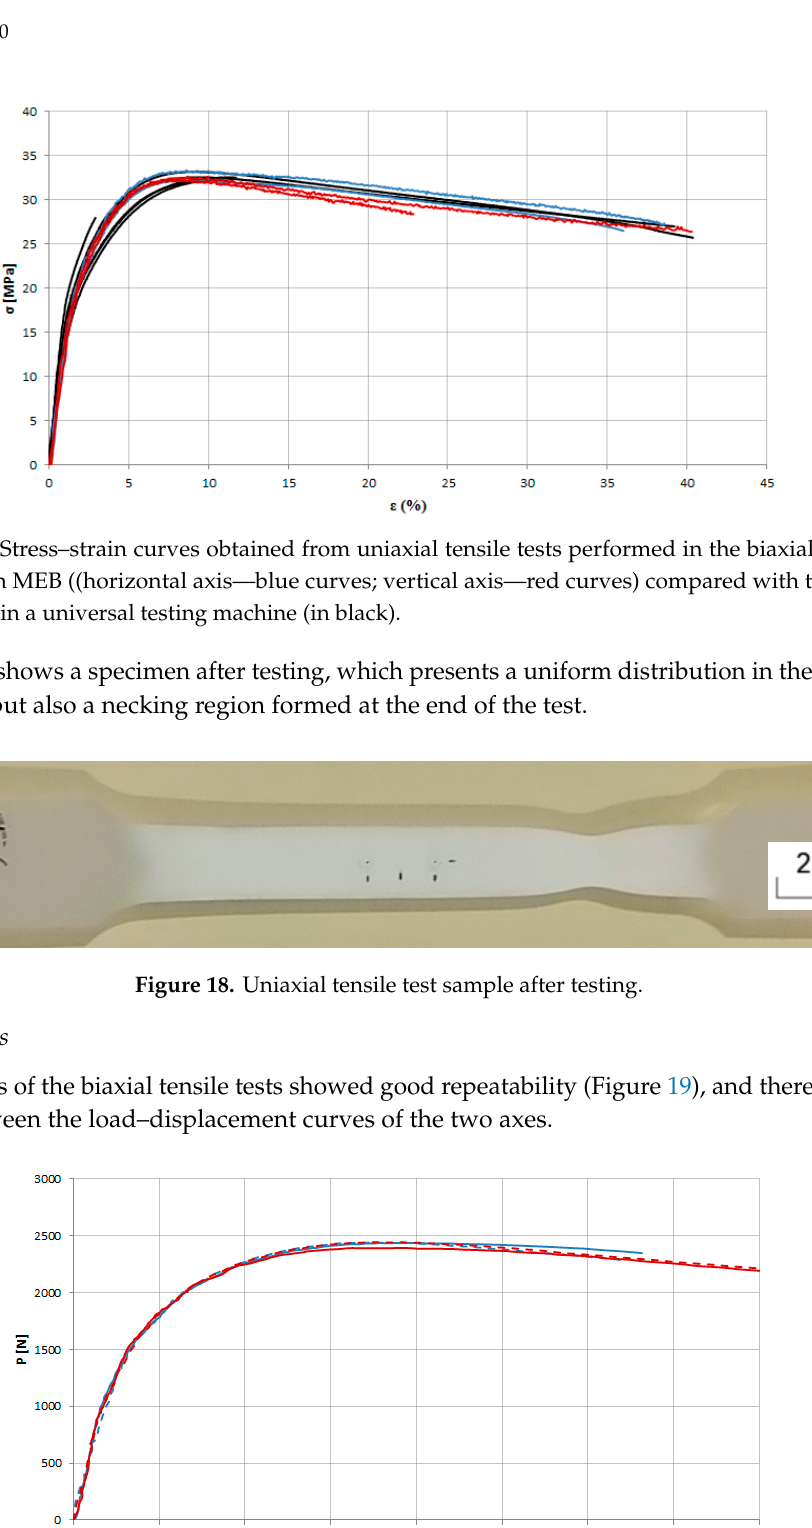
Figure 16. Stress–strain curves obtained from uniaxial tensile tests performed in the biaxial testing machine on MEB (horizontal axis—blue curves; vertical axis—red curves).